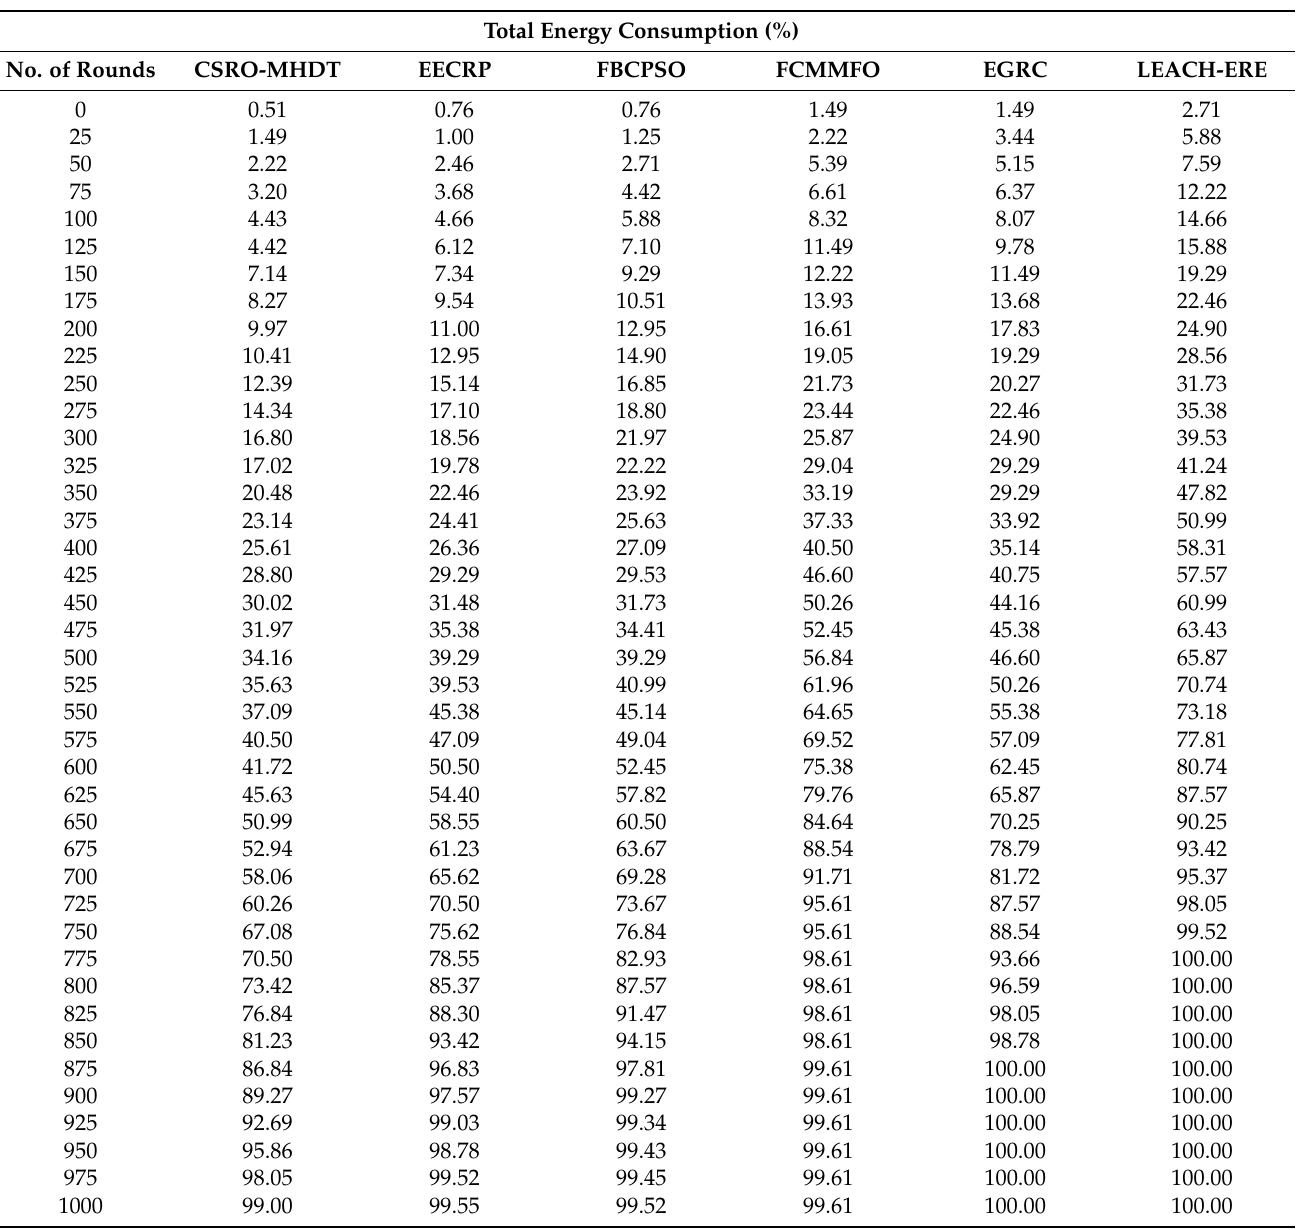
Table 4. TEC analysis of the CSRO-MHDT technique in comparison with existing approaches with different